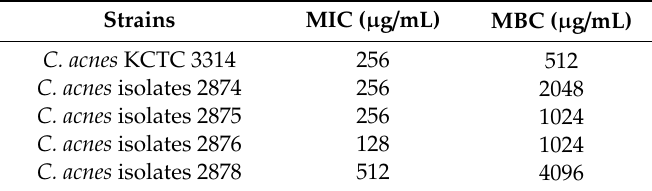
Table 1. Minimum inhibitory concentration (MIC) and minimum bactericidal concentration (MBC) of